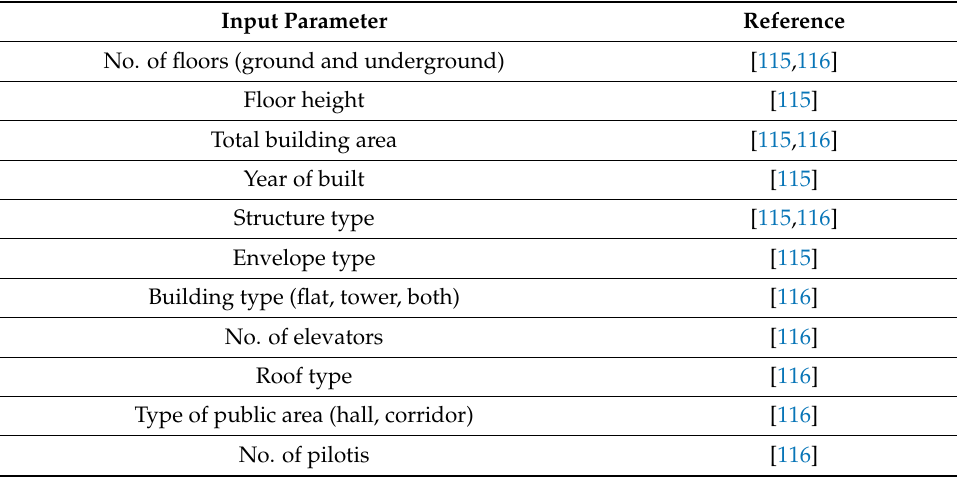
Table 7. List of input parameters deciding the maintenance cost of a building.